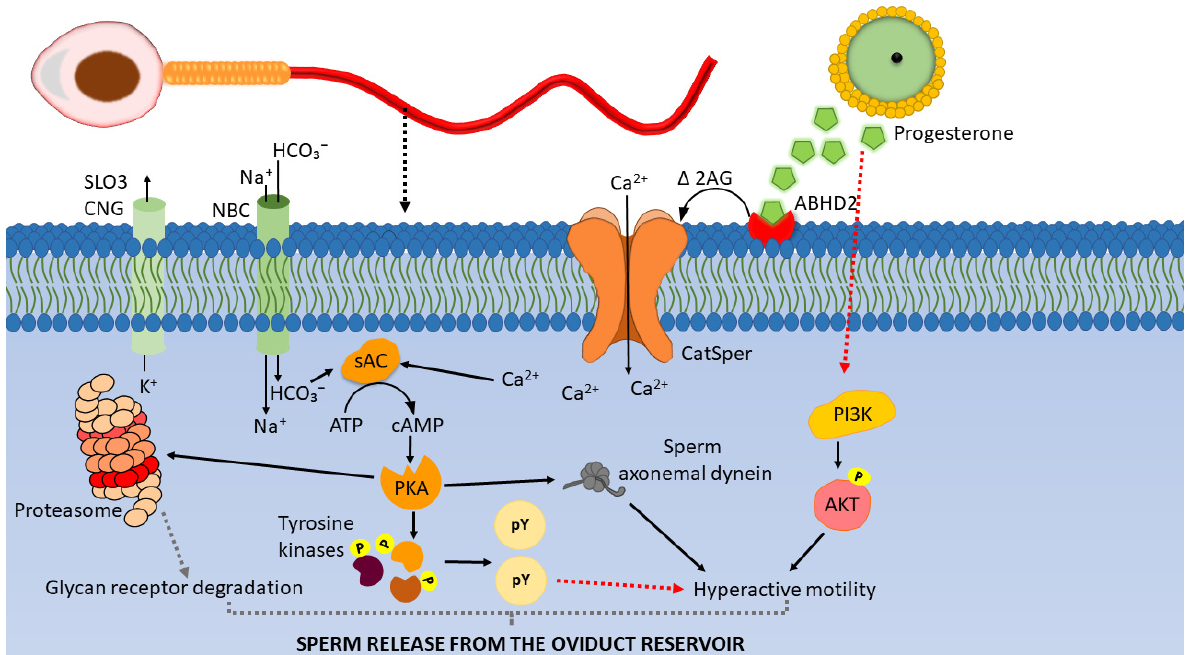
Figure 2. Working model of signaling events leading to sperm release from the oviductal reservoir. Progesterone binding to ABHD2 receptors on the sperm membrane depletes 2-arachidonoyl glyc- erol (2AG) and opens the CatSper channels permitting Ca 2+ entry. Ca 2+ and HCO 3- activate sAC which produces cAMP from ATP. cAMP activates Protein Kinase A (PKA). PKA (i) phosphorylates and activates sperm tyrosine kinases [80,81]. Tyrosine kinases phosphorylate the tyrosine residues of sperm proteins which leads to hyperactivated motility, (ii) associate with axonemal dynein, phos- phorylate them and regulate hyperactivated motility, (iii) phosphorylate sperm 26S proteasome subunits and activate proteasome activity, which may result in degradation of sperm glycan recep- tors. The combination of hyperactivated motility and glycan receptor degradation may facilitate sperm detachment from the oviduct sperm reservoir (modified from [82,83]). Progesterone induces hyperactivated motility of mammalian sperm [49,68]. The ma- jor characteristic of hyperactivated motility is increased flagellar bending amplitude, which causes increased asymmetrical beat pattern and swimming trajectories that are ei- ther helical or circular [84]. Hyperactivation increases the force that the sperm tail gener- ates [85,86] and, perhaps by doing so, overcomes the overall binding avidity of sperm for oviduct epithelial cells, inducing sperm release from the oviduct reservoir [87]. CatSper channels are essential for the development of hyperactivated motility in hu- man, rhesus macaque, and mouse sperm [68,88–92]. Interestingly, progesterone opens CatSper channels in human sperm, but not in mouse sperm [93,94]. That CatSper is acti- vated differently in sperm from certain species is notable. It suggests that progesterone may be less important in releasing mouse sperm from the oviductal reservoir than human sperm or perhaps macaque and porcine sperm. Although patch-clamp studies have not been carried out, the observation that inhibitors of ABHD2 and CatSper affect the re- sponse to progesterone by porcine sperm [34] suggests that progesterone acts on CatSper in sperm from species in addition to humans and monkeys. Several signaling events, presumably downstream of the progesterone-induced Ca 2+ influx, have been described (Figure 2). Progesterone-induced elevation of Ca 2+ activates soluble adenylyl cyclase (sAC) which, in turn, increases the activity of Protein Kinase A (PKA), increasing sperm protein serine/threonine phosphorylation and leading to sperm